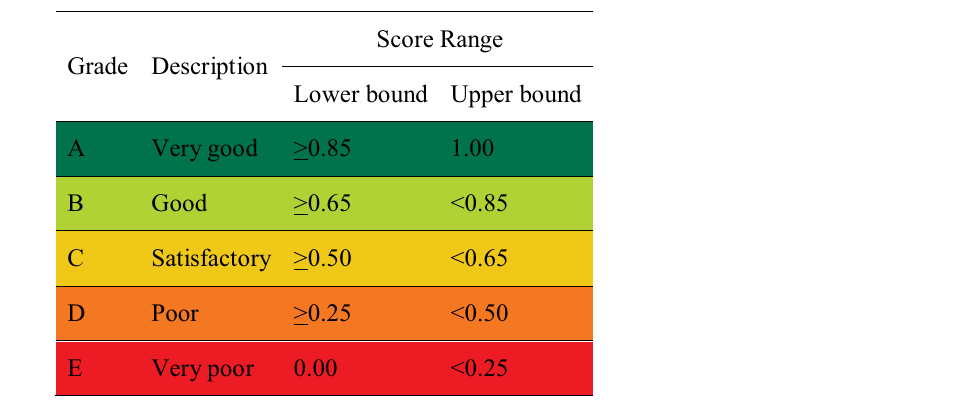
Table 1. Score range used in five-point grading system for the seagrass report card 6